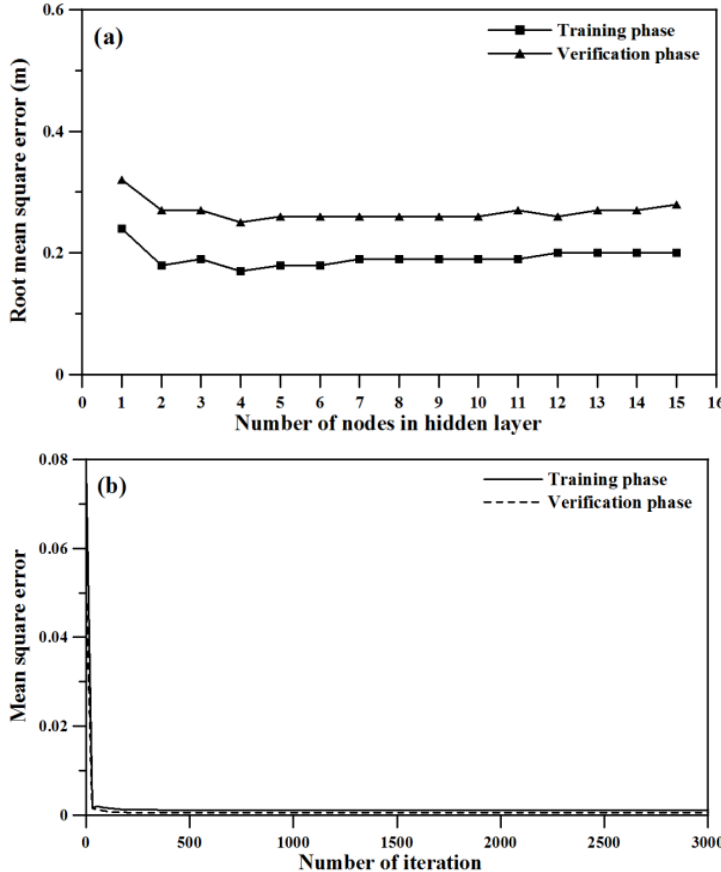
Figure 6. ( a ) The effect of the number of nodes in the hidden layer on the root-mean-square error (RMSE) at the Ru-Kou-Yan station; and ( b ) the variation in mean square error (MSE) with iterations.